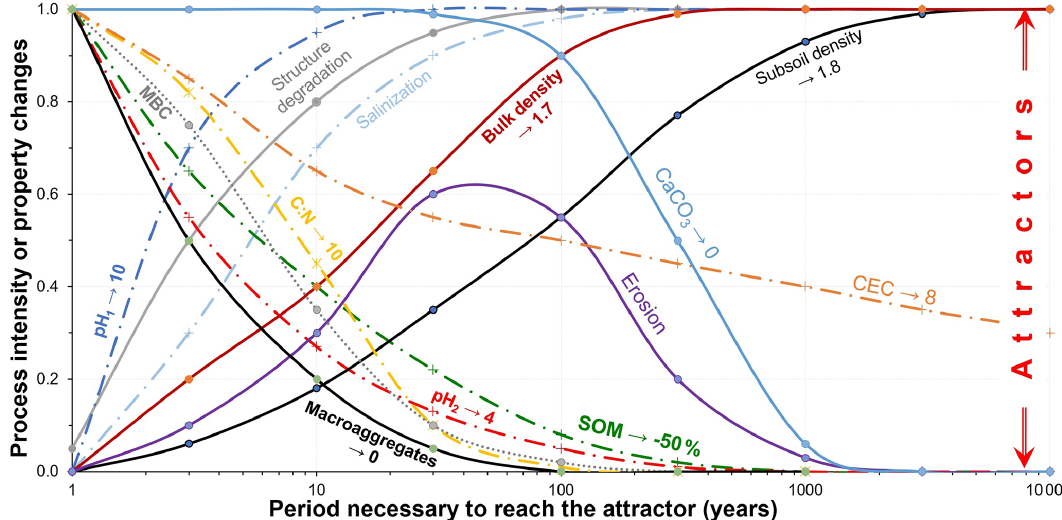
Figure 5. Overview on rates of key processes of agropedogenesis and their trajectory in reaching their attractors. Curves start from 0 or 1 (relative values) at the onset of cultivation and go to 1 or 0 for the specific attractors. Each curve is labelled with the specific property. Small arrows after each parameter title show the estimated level of attractor in absolute values. After approaching its attractor, each process slows down and finally stops. The timescale is logarithmic. Curve shape, time to reach attractor and attractor levels are only estimates and require future adjustment based on experimental data. pH 1 is for alkaline, and pH 2 is for acidic soils. Note that not all attractors are defined yet. Properties in bold are master soil properties for agropedogenesis (see Table 3). MBC is microbial biomass carbon, SOM is soil organic matter and CEC is cation exchange capacity. Continuous lines present physical properties or processes. Dotted–dashed lines correspond to chemical properties, and dotted lines correspond to biological